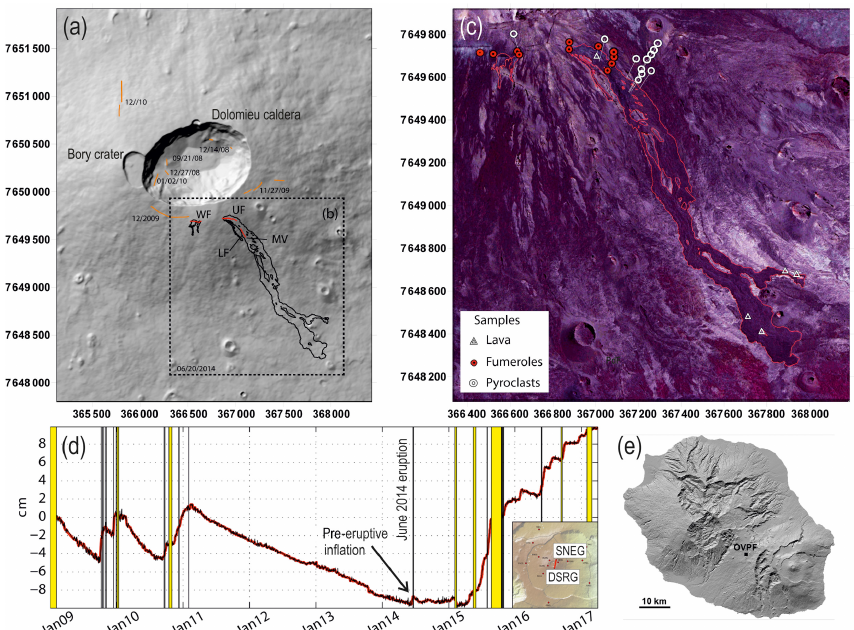
Figure 1. (a) Digital elevation model of the summit crater area at Piton de la Fournaise, La Réunion, France. Orange shows fractures generated by pre-2014 eruptions (reported are the dates of their activities); (b) red shows fractures active during the 2014 eruption: WF (western fracture), UF (upper fracture), LF (lower fracture), MV (main vent). Black shows the outline of the 2014 lava field. (c) Locations of sample collection points. The coordinates are in UTM, zone 40 south. (d) Distance change (baseline) in centimetres between two GNSS summit stations: DSRG and SNEG (see location in the inset). Increase and decrease in the signal mean a summit inflation and deflation, respectively. The yellow areas represent eruptive and intrusive periods. In (d) , the rapid and strong variations linked to dike injections preceding intrusions and eruptions by a few tens of minutes have been removed. (e) Digital elevation model of La Réunion island.